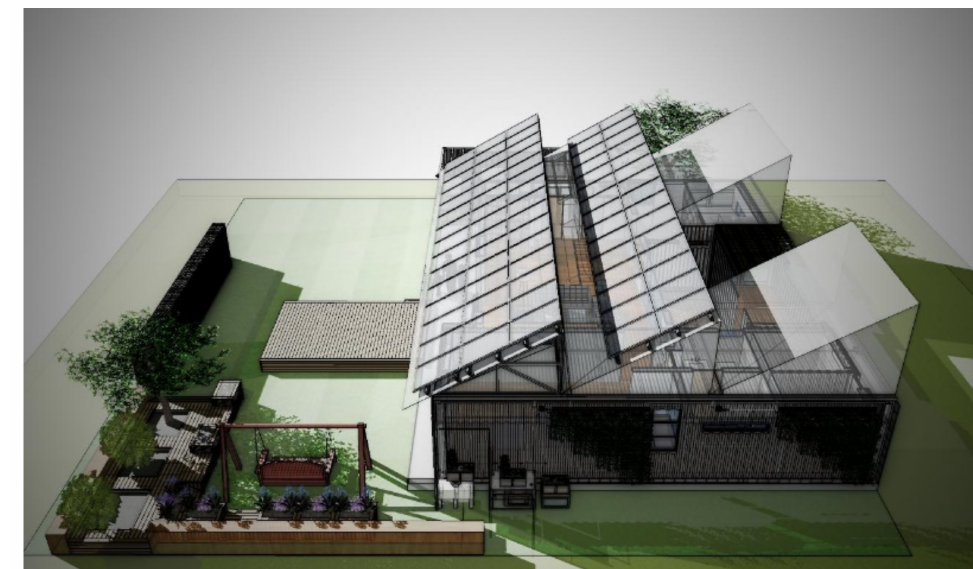
Figure 11. A passive design case for single-family house in Stockholm,